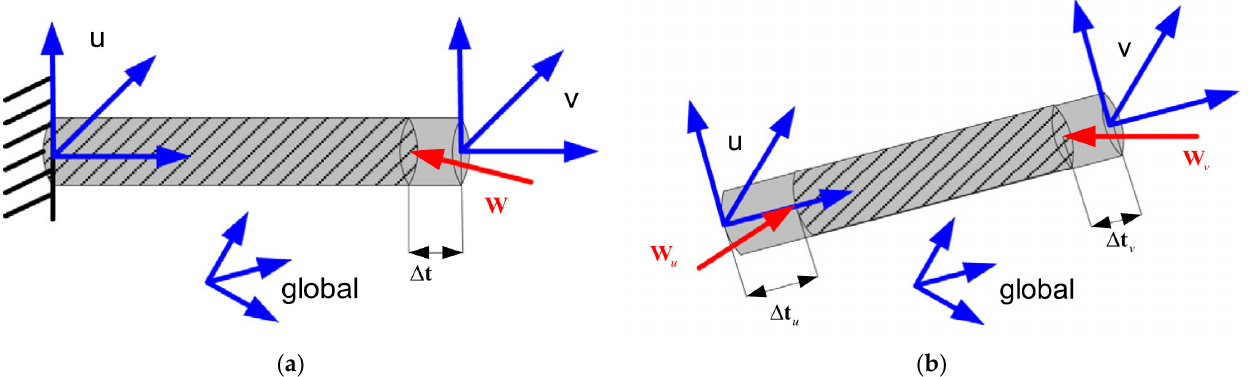
Figure 4. Deflections and wrenches of beam structural units [63]: ( a ) cantilever beam and ( b ) unsupported beam.